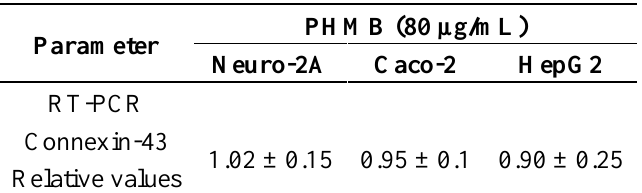
Table 14. Quantification by ELISA of Connexin 43 in the cellular homogenate following 24 h incubation with 80 µg/mL